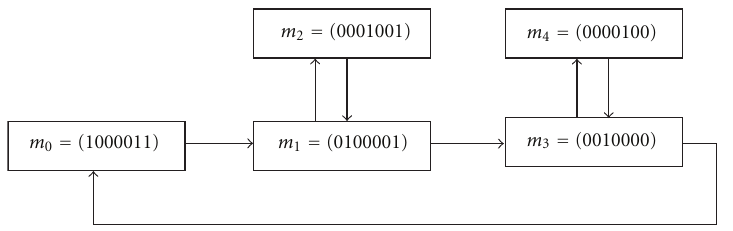
Figure 8: Markov chain and reachability graph of the modeled system.